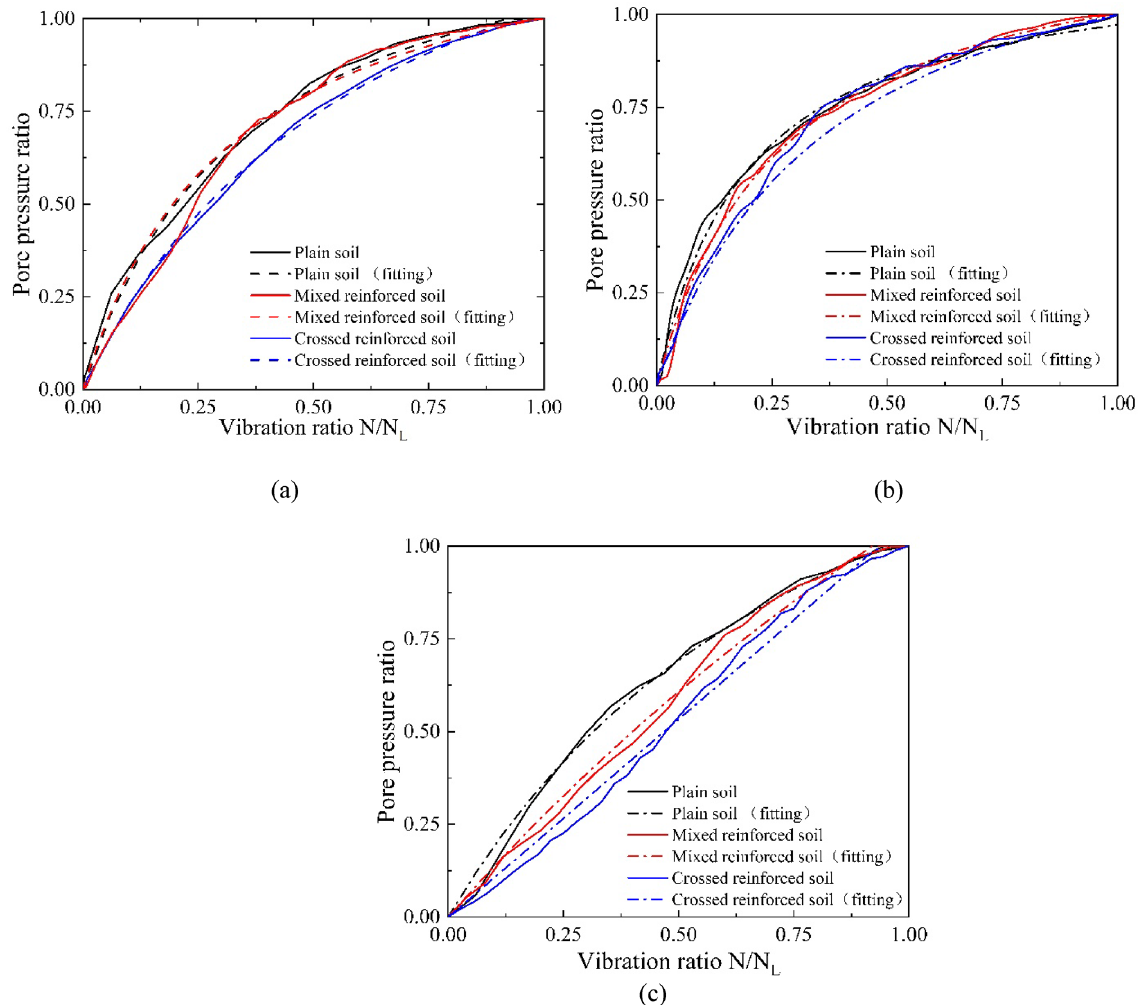
Figure 10. Relationship between pore pressure ratio and vibration ratio computed by proposed model: ( a ) dynamic stress amplitude of 15 kPa, ( b ) dynamic stress amplitude of 20 kPa, and ( c ) dynamic stress amplitude of 25